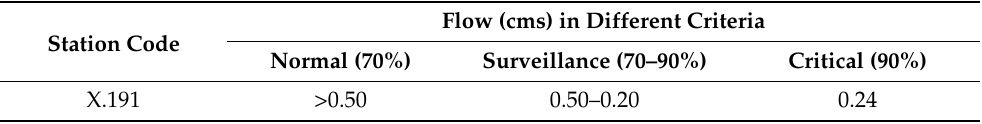
Figure 5. The flow duration curve of X.191 station (Satree Phuket School). Source: Southern Region Irrigation Hydrology Center, Royal Irrigation Department [51]. Table 6. The criteria of minimum water from the flow duration curve.